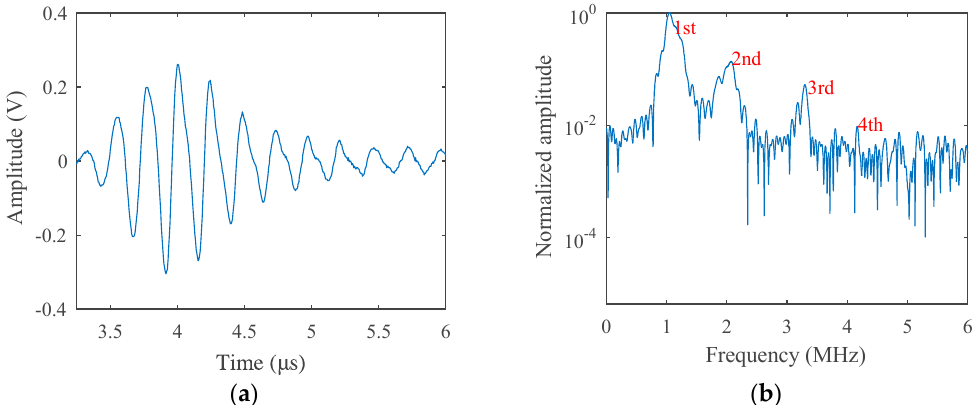
Figure 8. ( a ) Transmitted signals received from the fatigue sample (Loading Cycle 5000) in the time-domain and ( b ) in the frequency-domain (excitation voltage 200 V).